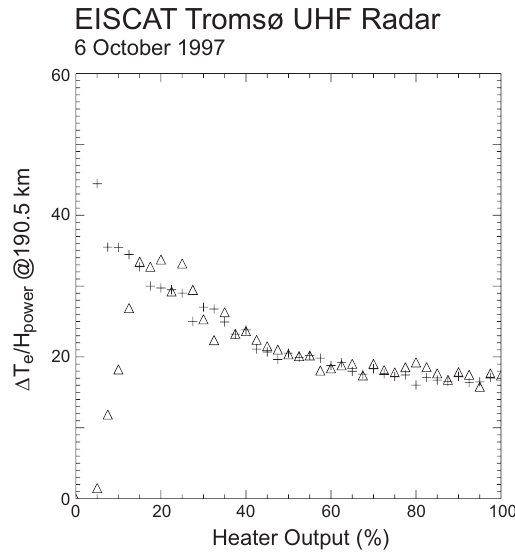
Fig. 7. The temperature change of the electrons in the modified ionosphere normalised by and plotted as a function of the heater output power. Again the up- and down-going parts (respectively symbolised by 1 and +) of the same heater cycle as in Fig. 4 are overlaid to illustrate the hysteresis